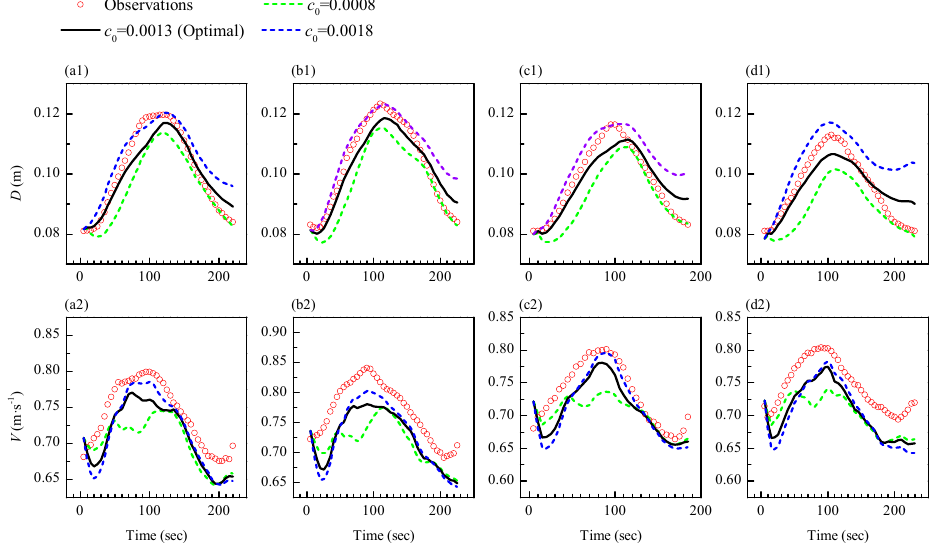
Figure 7. Simulation results of the original SVN model with different parameter values: ( a1 ) flow depth hydrograph and ( a2 ) sectional averaged velocity hydrograph for No. 1-1 flood event; ( b1 ) flow depth hydrograph and ( b2 ) sectional averaged velocity hydrograph for No. 1-2 flood event; ( c1 ) flow depth hydrograph and ( c2 ) sectional averaged velocity hydrograph for No. 2-1 flood event; and ( d1 ) flow depth hydrograph and ( d2 ) sectional averaged velocity hydrograph for No. 2-2 flood event.